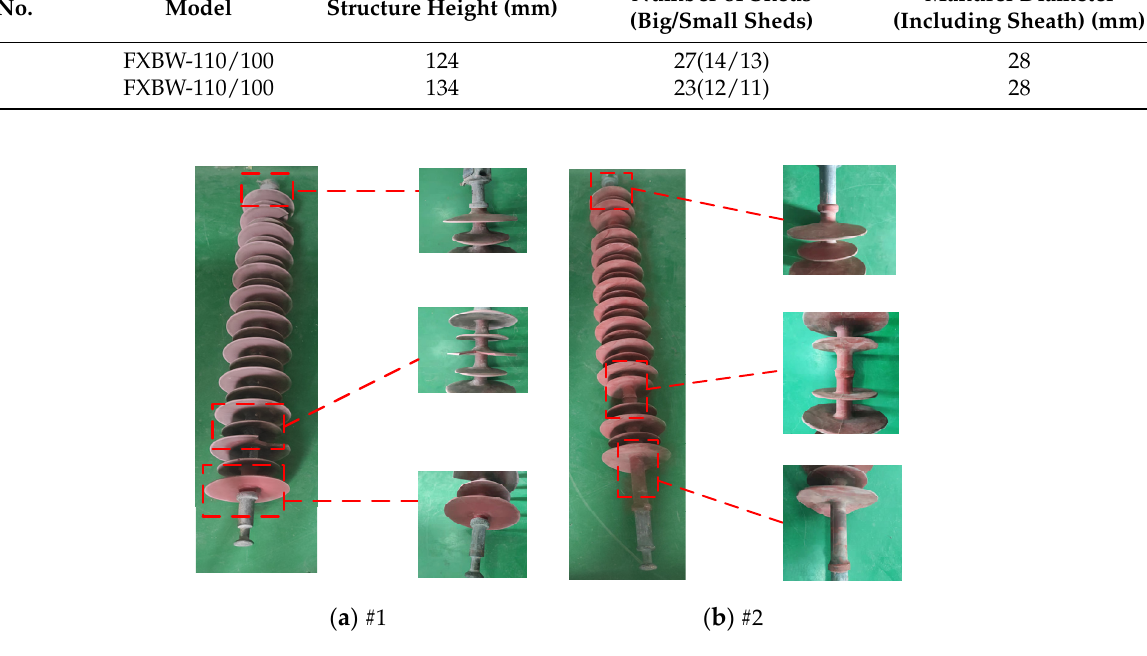
Figure 2. Appearance of abnormal heating composite insulator. ( a ) appearance of #1; and ( b ) appearance of #2.